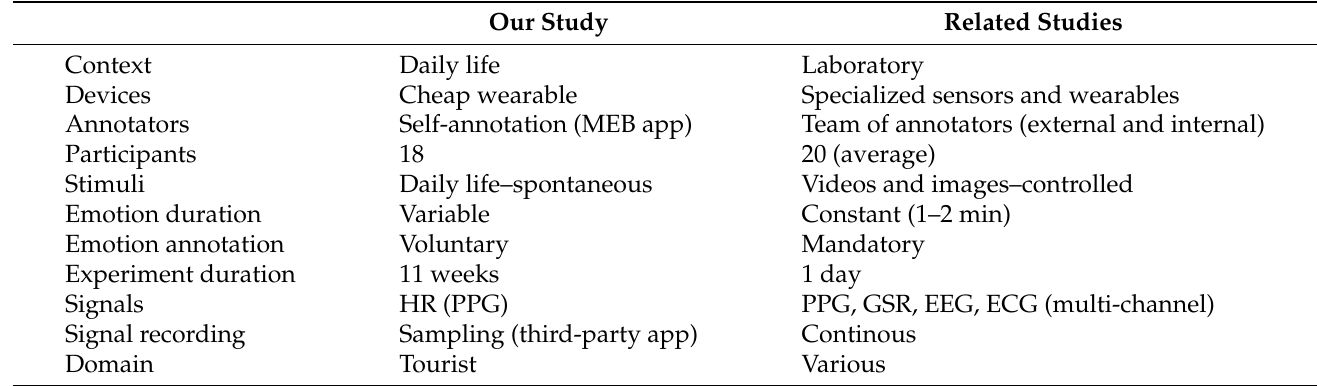
Table 7. Di ff erences between emotion recognition